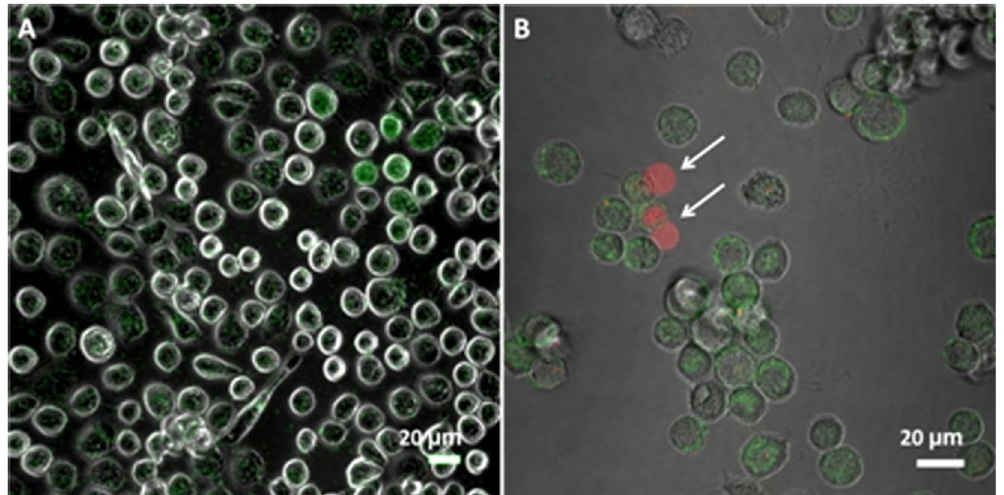
Figure 4. Confocal fluorescence (calcein, PI) merged with low intensity transmitted phase contrast images acquired on HaCaT cells treated for 30 ′ ( A ) and 45 ′ ( B ) with 1 MHz US at I spta = 7 mW/cm 2 ; in the second image ( B ) white arrows indicate the colocalization of calcein and PI in the cells, pointing out the failure of the recovery process after the